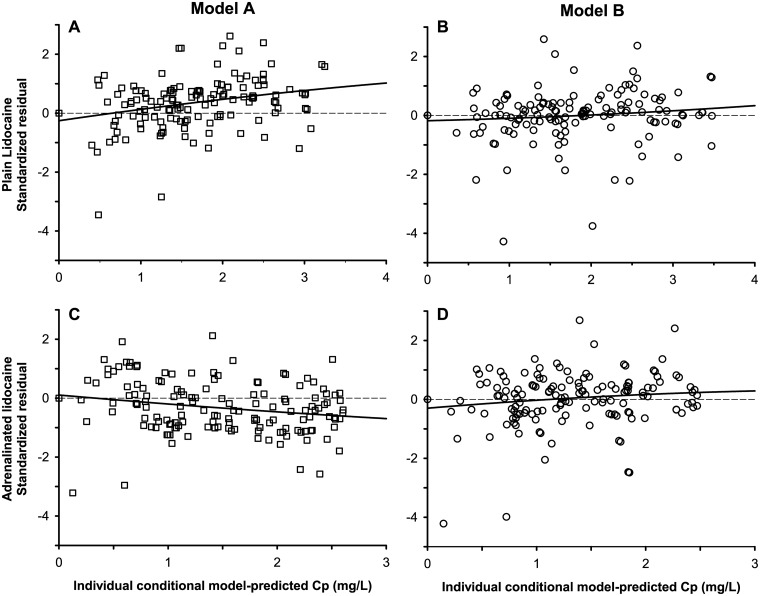
Lidocaine standardized residuals of the standard and alternative compartmental models vs. model-predicted plasma lidocaine concentration.(A) Plain lidocaine data predicted by Model A (i.e. one single first-order absorption rate per system). (B) Plain lidocaine data predicted by Model B (i.e. two asynchronous first-order absorption rates per system). (C) Adrenalinated lidocaine data predicted by Model A. (D) Adrenalinated lidocaine data predicted by Model B. A third degree polynomial curve (continuous line) has been added to highlight the trend in the residuals.